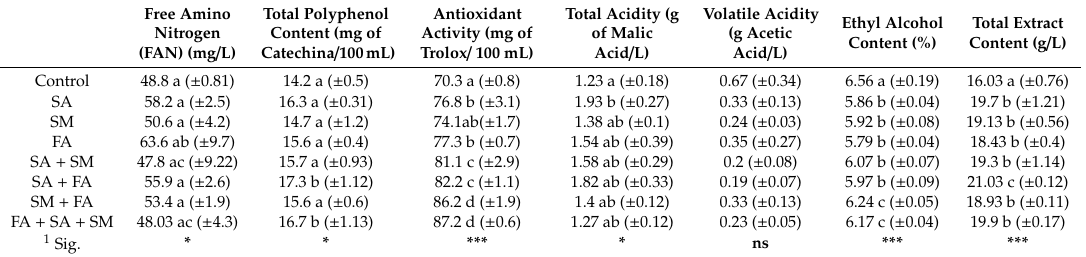
Table 7. Physicochemical parameters for ciders fermented by cider yeast (C), with the following additions: SA—ammonium sulfate, SM—magnesium sulfate, FA—ammonium phosphate.